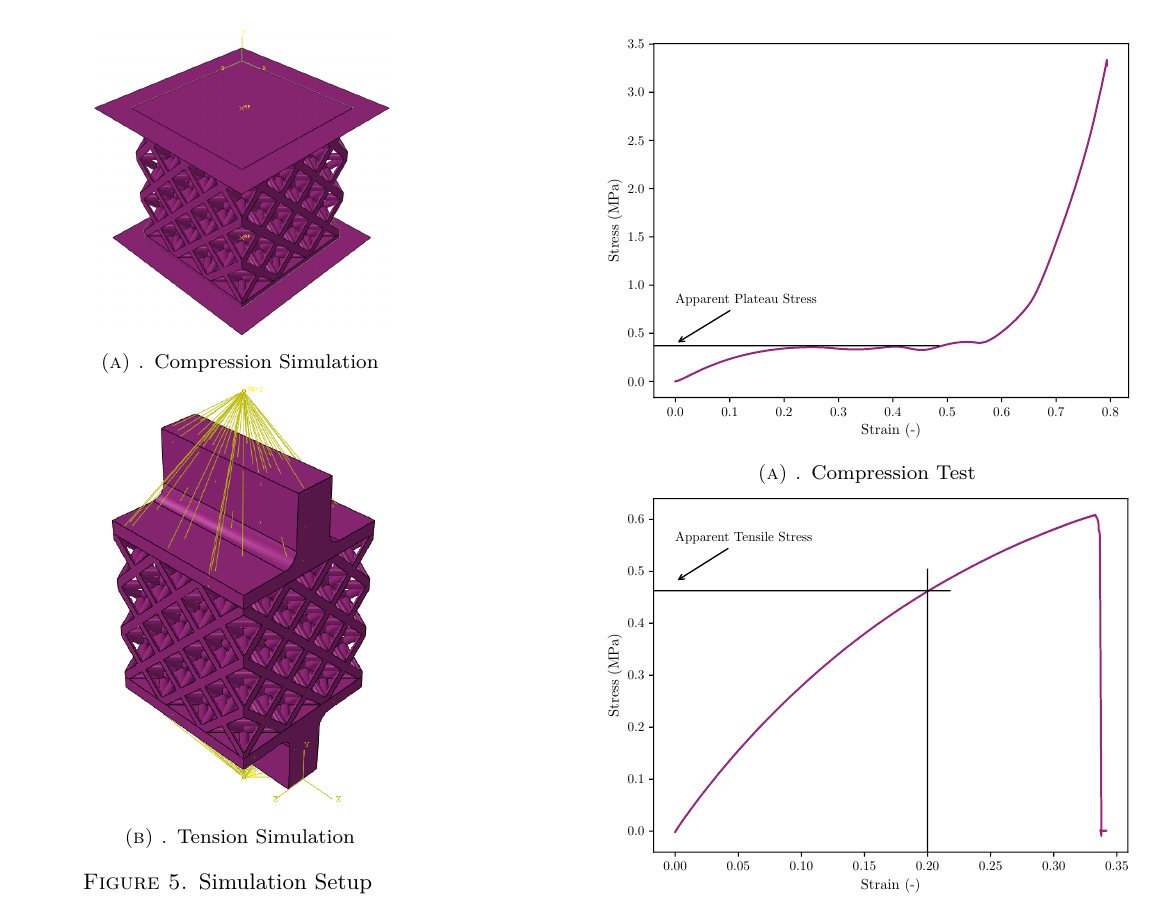
Table 2. Experimental Results